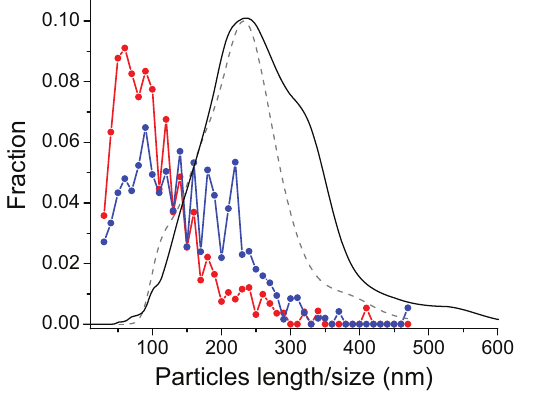
Figure 2. Size distribution of A b 42 CC protofibrils measured using different methods. The blue and red lines/symbols represent data from atomic force microscopy. One sample (blue) was washed briefly with deionized water, while a second sample (red) was washed extensively. The lengths of ca. 1500 protofibrils were measured in each case. The gray dashed line reflects an expected distribution corre- sponding to the analytical ultracentrifugation measurements (Fig. 3) assuming that A b 42 CC protofibrils have a dehydrated diameter of 3.1 nm. The black line represents the distribution of apparent hydrodynamic radius obtained from nanoparticle tracking analysis using a NanoSight microscope.